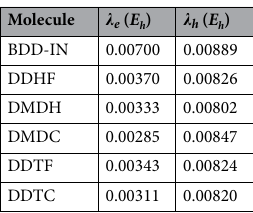
Table 3. Reorganization energy of BDD-IN, DDHF-DDTC molecules. (cid:31) e : Rate of transfer of electrons, (cid:31) h : rate of transfer of